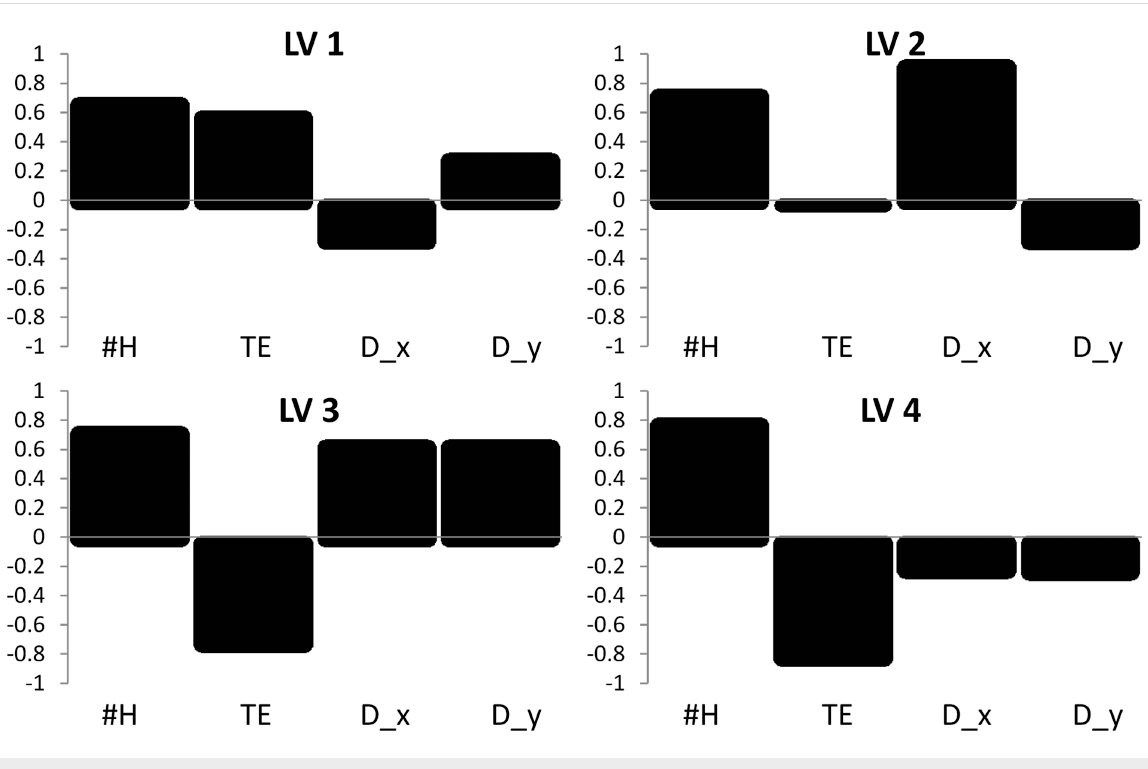
rine (Br = 2.96, Cl = 3.16, Pauling scale), congeners more chlo- rinated than brominated would have a higher dipole moment along the x axis of dioxin, and in effect, higher predicted